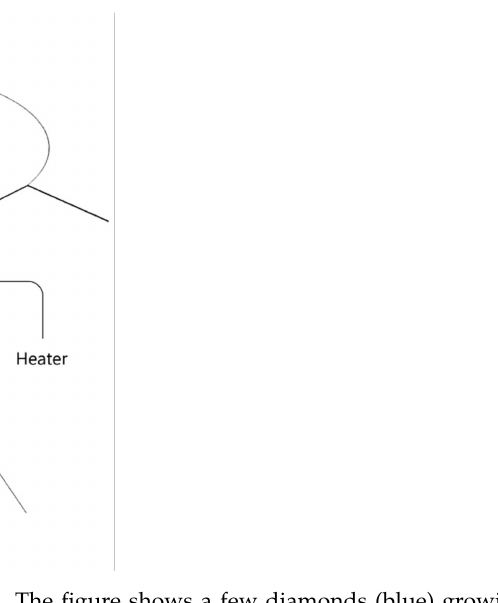
Figure 1. A HPHT belt-type chamber. The figure shows a few diamonds (blue) growing in an iron-based melt (orangish) inside a heated chamber under